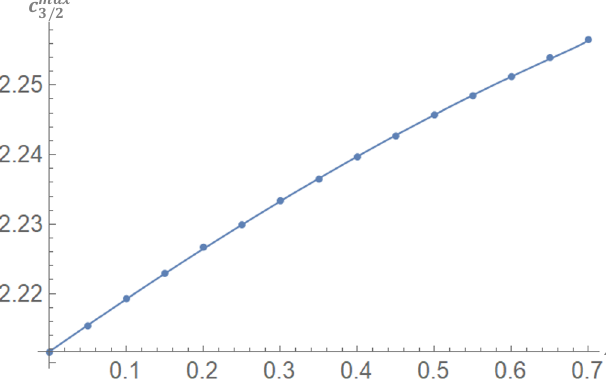
( ∞ ) increases as λ becomes larger, but is always less than Figure 3 . The coefficient c max ≡ c 3 / 2 3 / 2 when λ ≤ λ c ∼ 0 . 70 , for which the charge Q is unbounded above. c RN 3 / 2 is an upper bound for the parameter λ , namely λ c ∼ 0 . 70 , beyond which, the charge